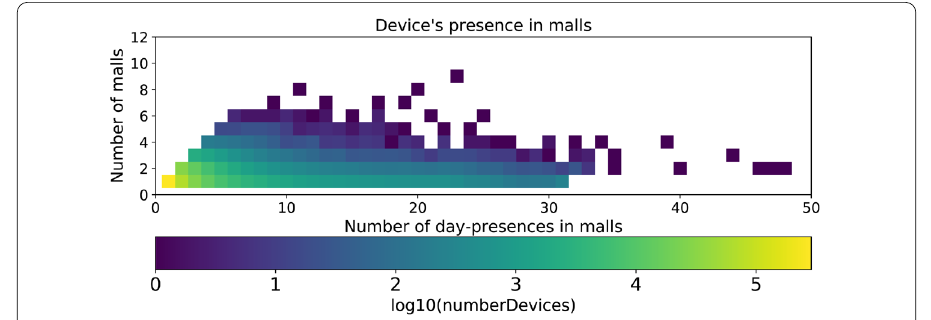
Figure 2 Heatmap representing the number of devices that performed a certain number a mall visits during the month ( x -axis), and whose visits spanned a certain number of different malls ( y -axis). A white color represents that no devices were found under those conditions